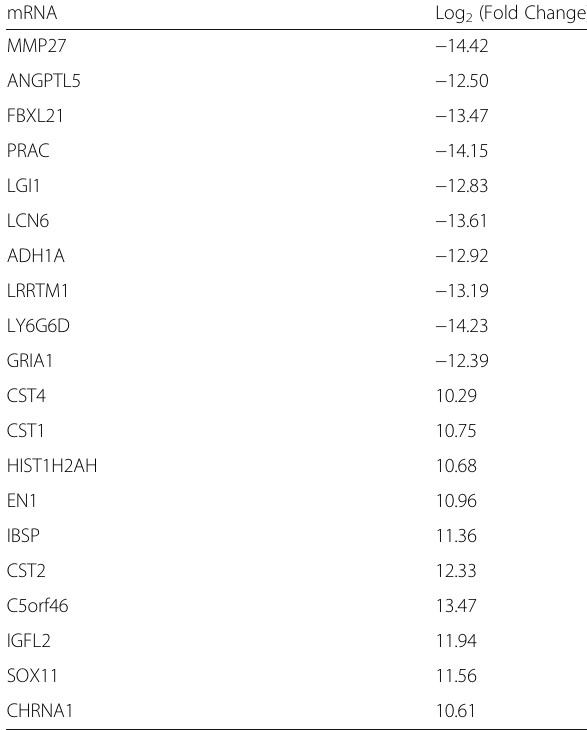
Table 3 Log 2 (Fold Change) of ten increased circular RNA and ten decreased circular RNA Circular RNA